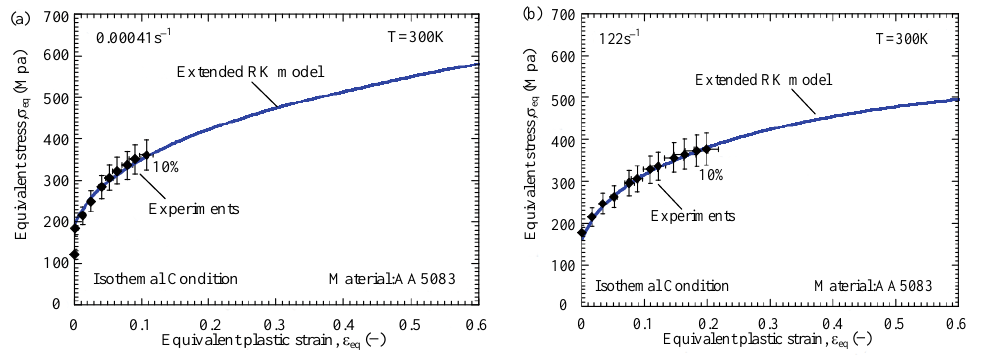
Figure 19. NSRS description using extended RK model [45], ( a ) 0.00041 s − 1 ; ( b ) 122 s − 1 .